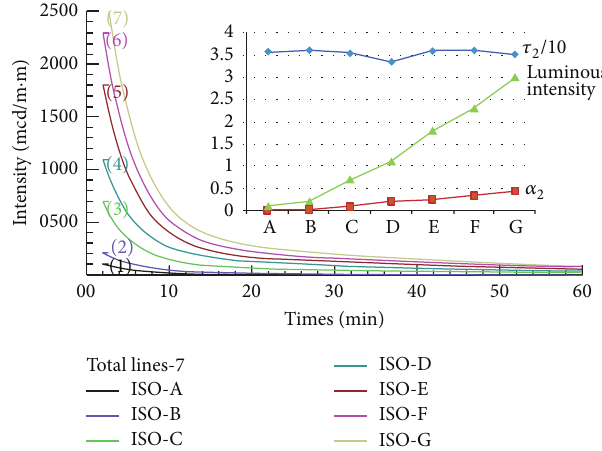
Figure 3: Afterglow profiles of the DIN luminous standard where the luminous intensity is measured at 2min.